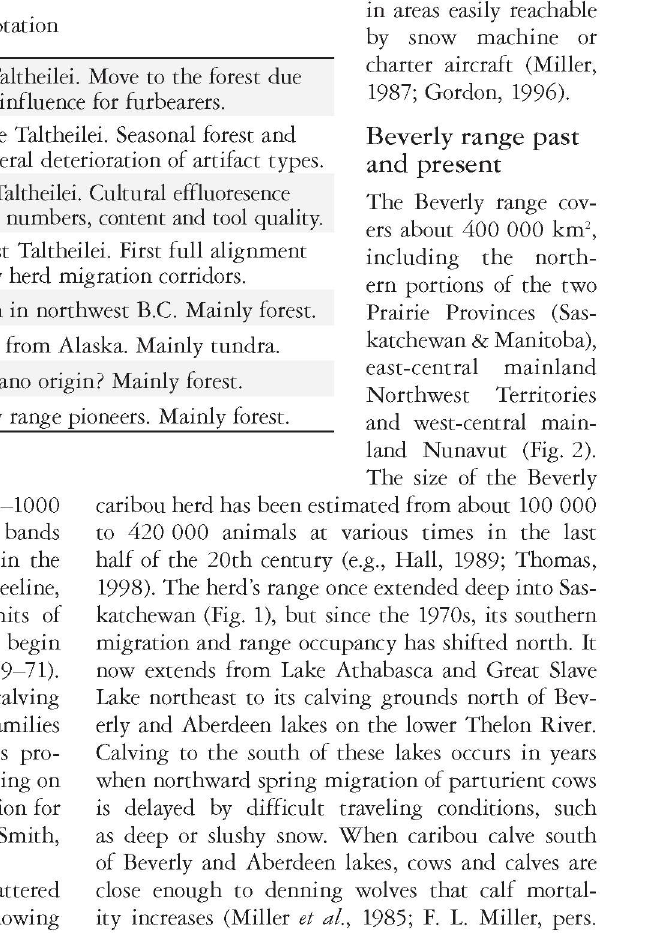
Table 1. Cultures occupying the Beverly caribou range over the past 8000 years.